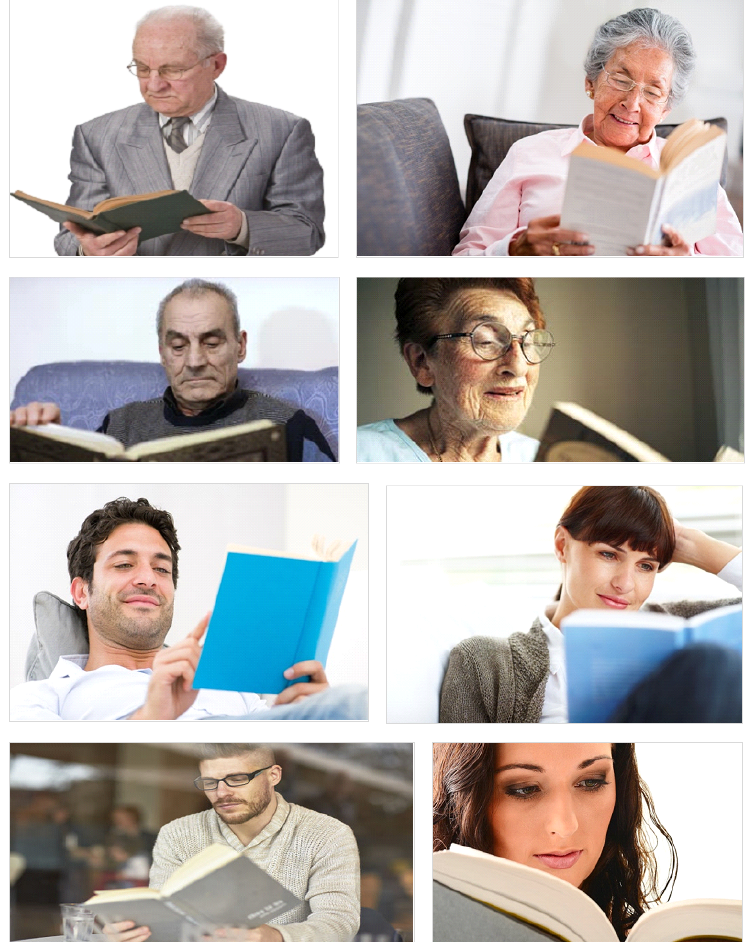
Figure 1. People depicted on the questionnaires (copyright free images taken from [25] with permis- sion of the author), including older people (top four), younger people (bottom four), men (on left) and women (on right). Only one picture was included on each